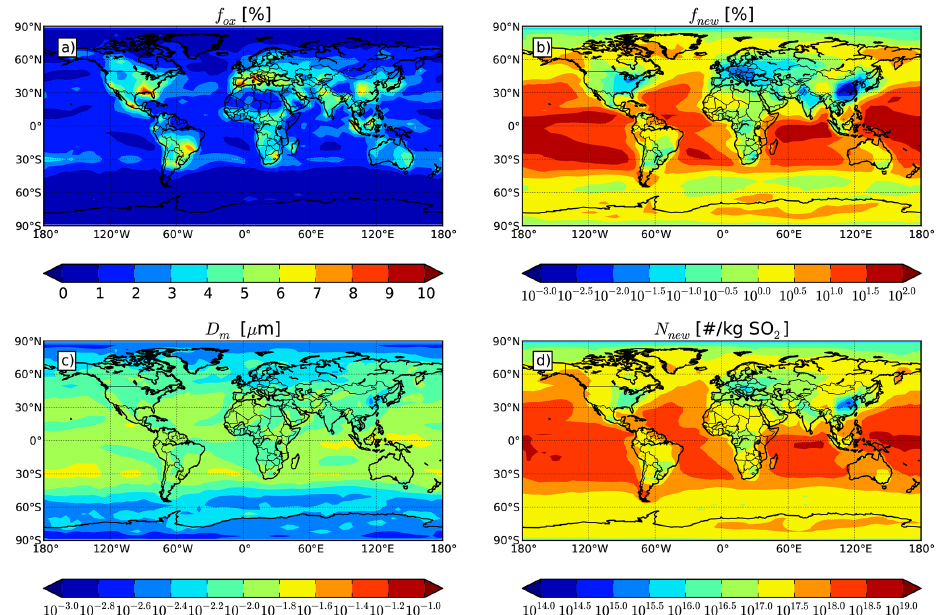
Figure 4. Annually averaged outputs of the P6 parameterization, as calculated offline from monthly-means of the P6 inputs for simulation P6_nXSOA_Napa: (a) fraction of emitted SO 2 oxidized ( f ox ), (b) fraction of H 2 SO 4 formed that comprises new particles ( f new ), (c) median diameter of emitted particles ( D m ), and (d) number of new particles per kg SO 2 emitted ( N new ). We note these values are calculable even in the absence of emissions, see Sect.